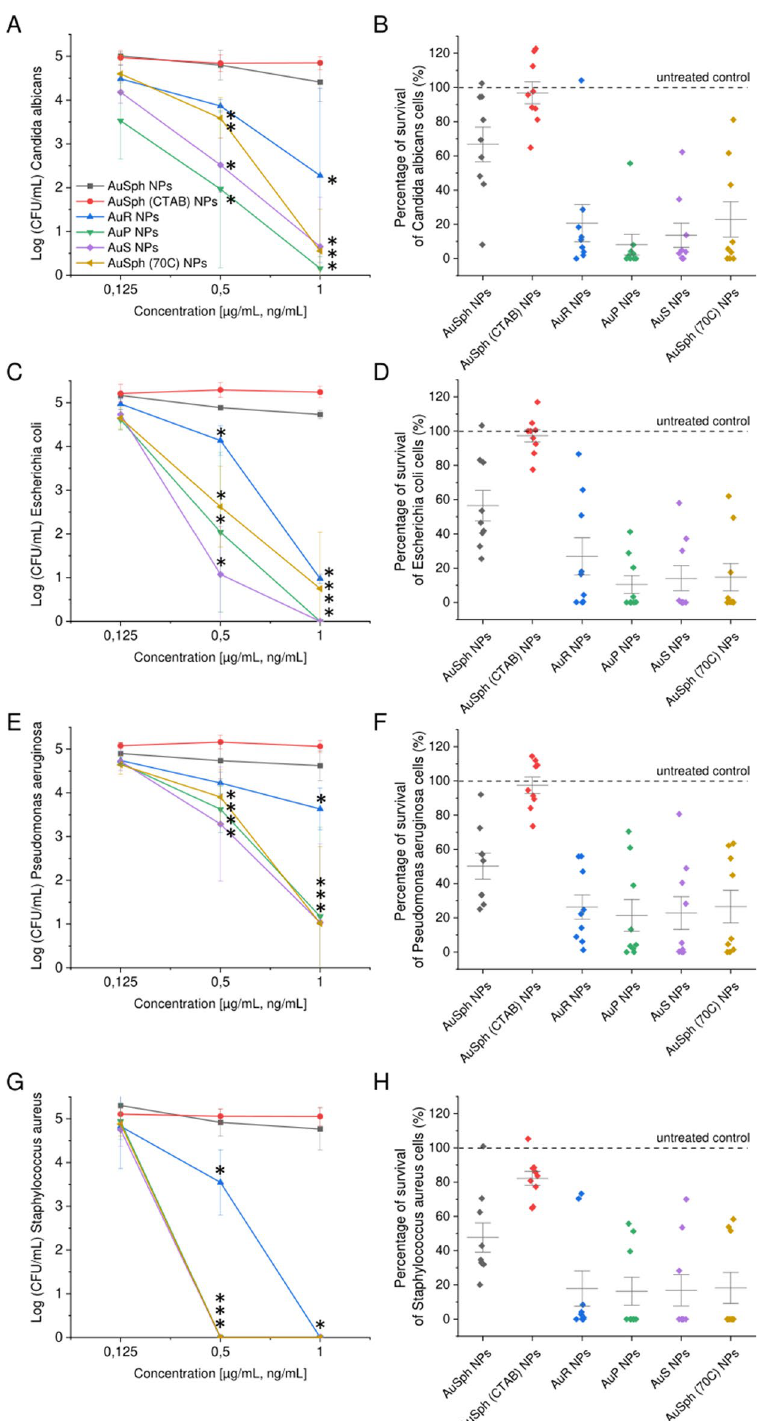
Figure 2. Antimicrobial activity of varied-shaped gold nanoparticles. Killing efficiency of spherical, nonfunctionalized gold nanoparticles (AuSph NPs; black line), CTAB-functionalized spherical nanoparticles [AuSph (CTAB) NPs; red line], gold nanorods (AuR NPs; blue line), gold nanopeanuts (AuP NPs; green line), gold nanostars (AuS NPs; violet line) and porous spherical-shaped gold nanoparticles [AuSph (70C) NPs; gold line] against representative isolates of C. albicans [n = 3, ( A ) and ( B )], E. coli [n = 3, ( C ) and ( D )], P. aeruginosa [n = 3, ( E ) and ( F )] and S. aureus [n = 3, ( G ) and ( H )] was tested using colony counting assay using doses of 0.125, 0.5 and 1 µg mL −1 (for AuSph NPs) or 0.125, 0.5 and 1 ng mL −1 (for other nanostructures). Results are presented as mean ± SD from 3 representative strains. *Indicates statistical significance (p < 0.05) when compared to untreated